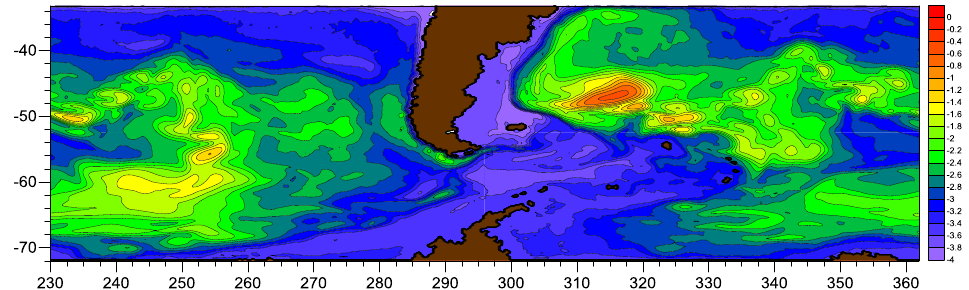
Fig. 6. Logarithm of the rms of the low-frequency SSH signal.